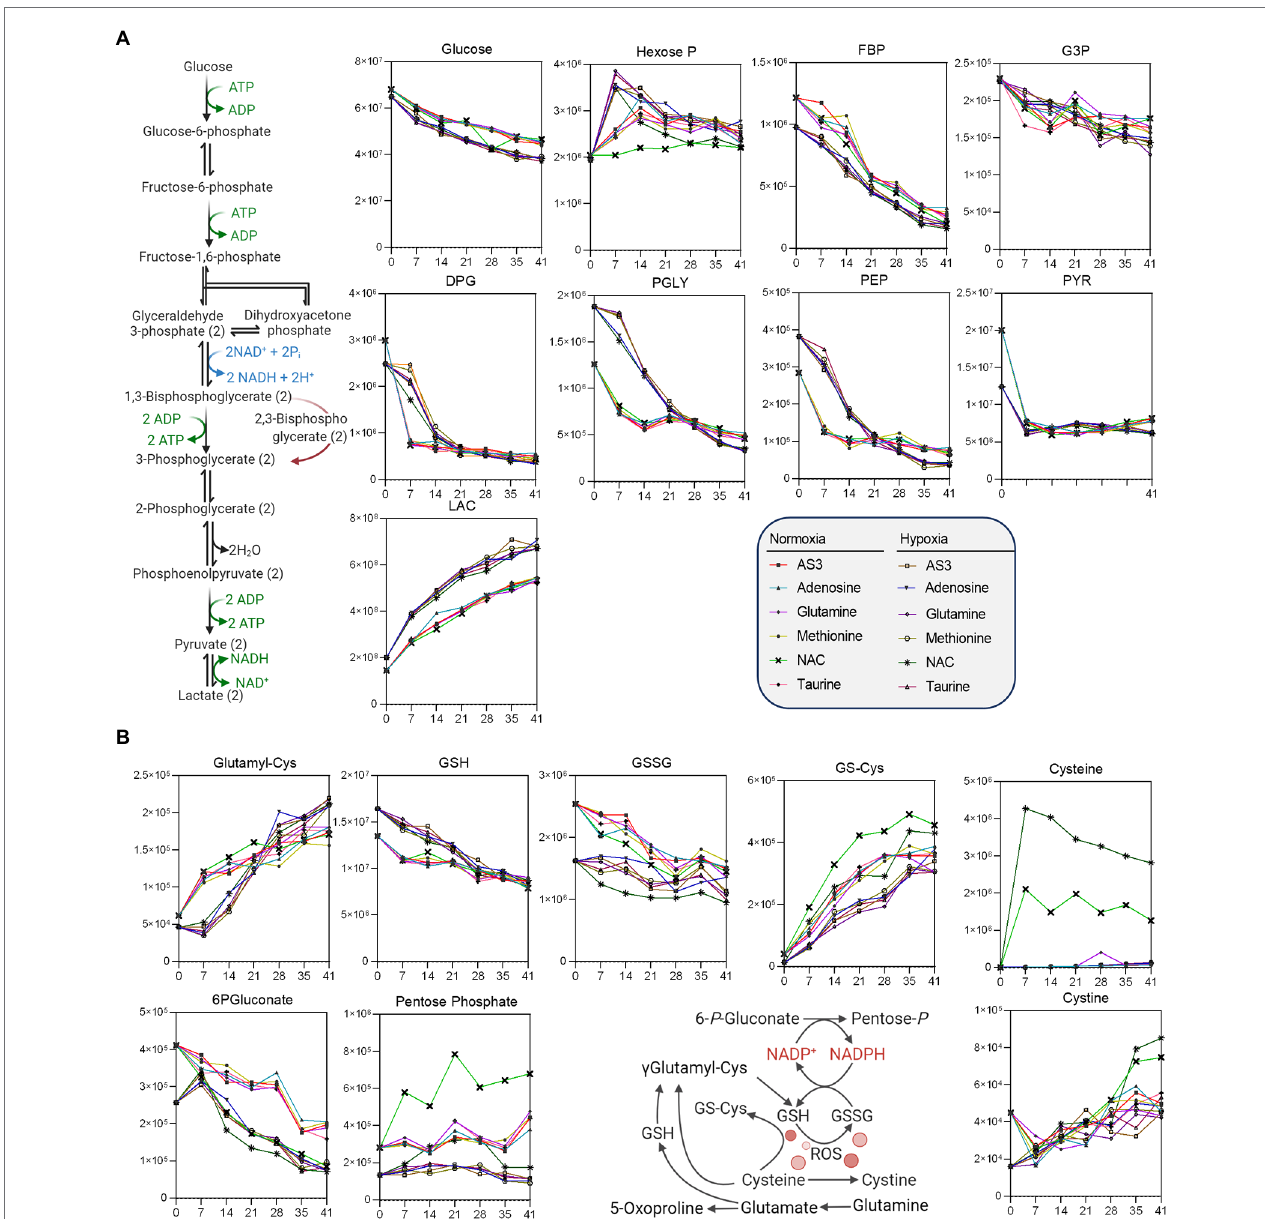
FIGURE 4 | Impact of hypoxia and storage additives on (A) glycolysis, (B) the pentose phosphate pathway, and (B) glutathione